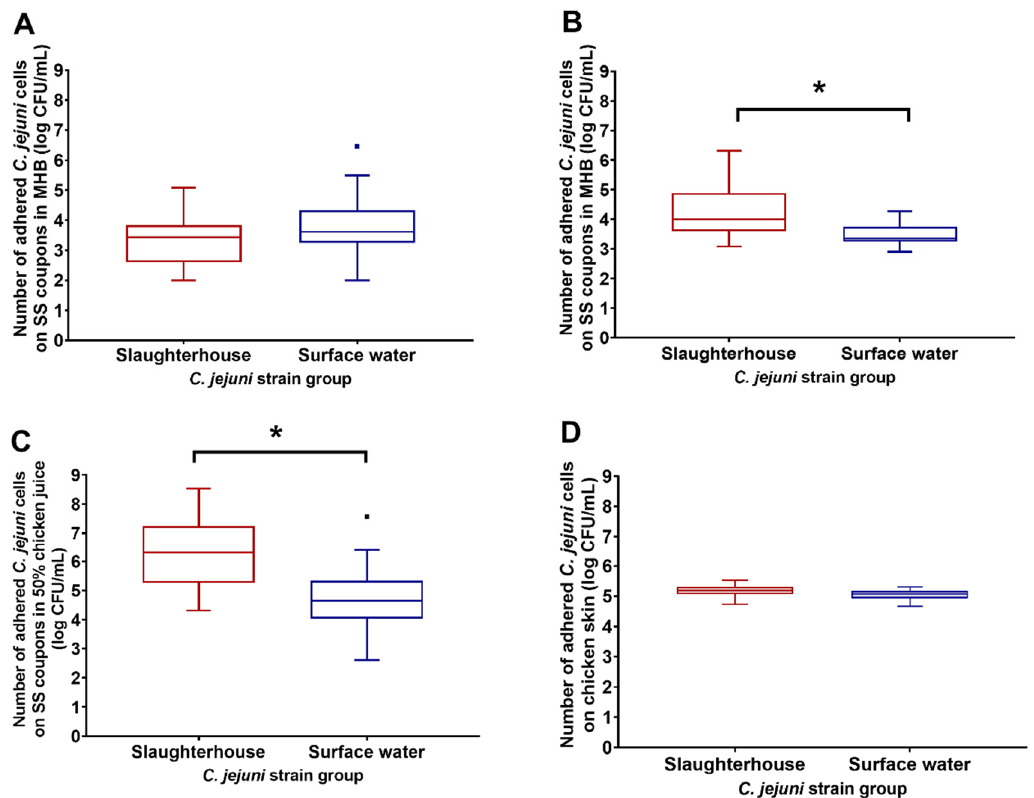
Figure 1. Adhesion (log CFU/mL) as the pooled data for the Campylobacter jejuni slaughterhouse and surface-water environment isolates to stainless steel (SS) coupons in Mueller–Hinton broth (MHB) for 72 h under microaerobic conditions at 37 °C ( A ) and 42 °C ( B ), in MHB with 50% chicken juice for 72 h under microaerobic conditions at 37 °C ( C ), and to chicken skin in phosphate-buffered saline (PBS) for 3 h at 4 °C ( D ). CFU—colony forming units. *Statistical significance at p < 0.05; dots present outliers.